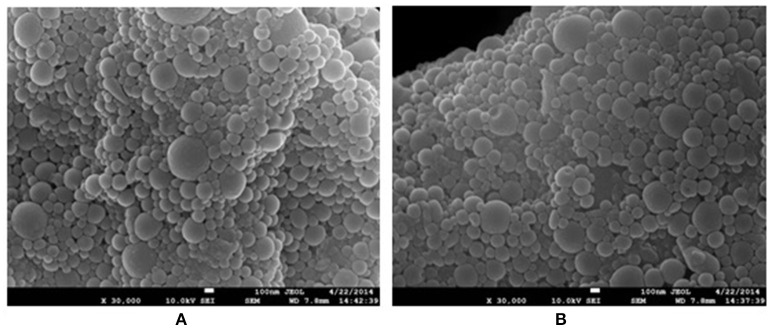
SEM image of PLGA-SynORF5 NPs (A) and PLGA-GP5 NPs (B), showing their size and morphology.